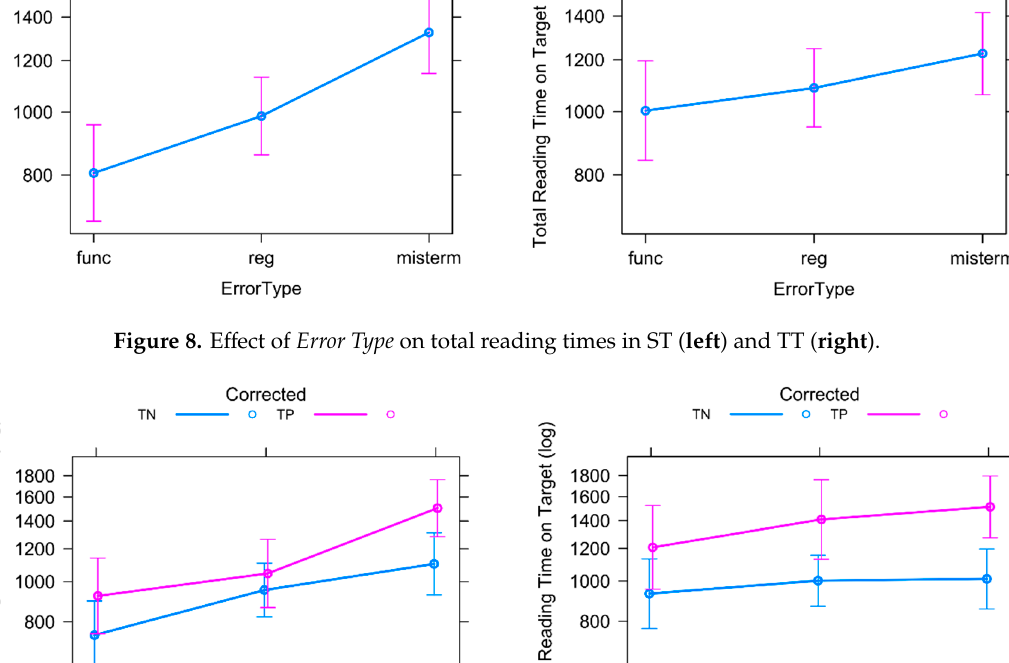
Figure 8. Effect of Error Type on total reading times in ST ( left ) and TT ( right ).